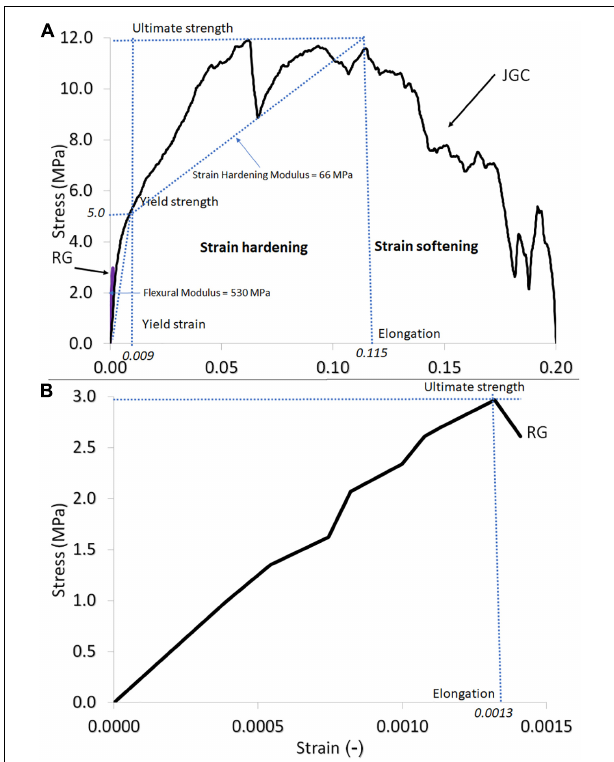
FIGURE 8 | Typical stress–strain curves of JG composite (A) and reference geopolymer (B) .